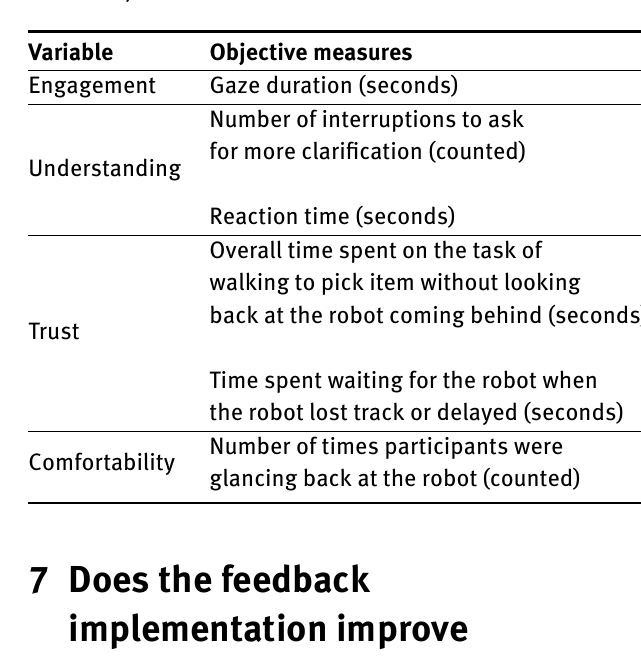
Table 3: Objective